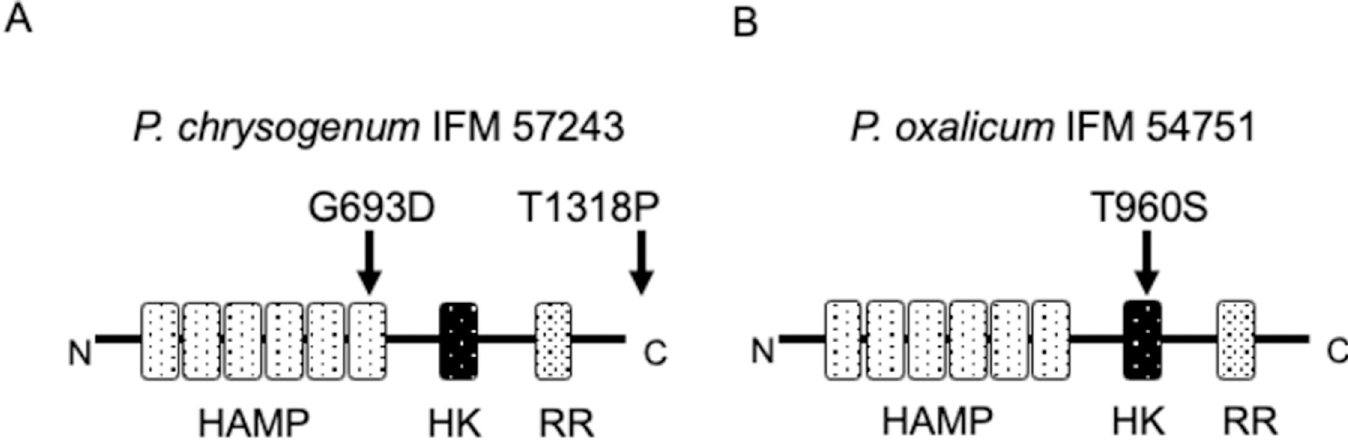
Fig 3. Domain structures of fungal NikA proteins. The group III HHK NikA is composed of six repeated HAMP, histidine kinase (HK), and response regulator (RR) domains. (A) The mutation G693D in P . chrysogenum IFM 57243 is located in the HAMP domain, whereas the mutation T1318P is located in a disordered region. (B) The mutation T960S in P . oxalicum IFM 54751 is located in the HK